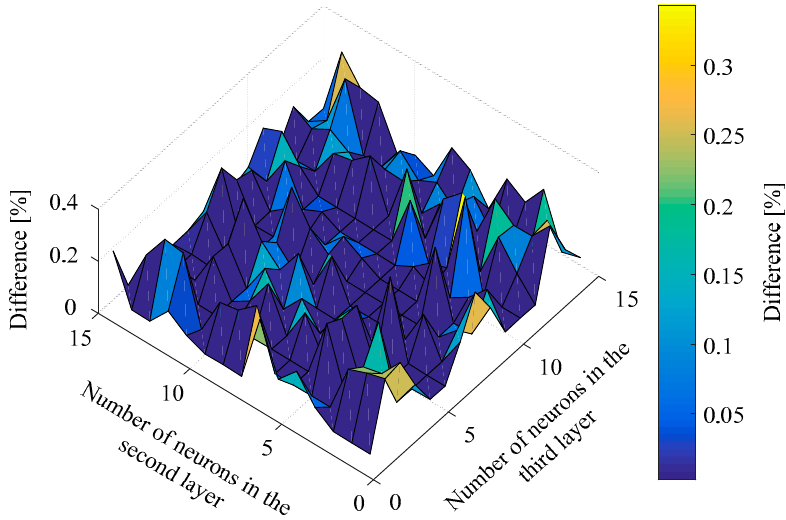
Figure 6. Validation of the FFBN when the network consisted of three hidden layers, when the first layer consisted of 18 neurons.